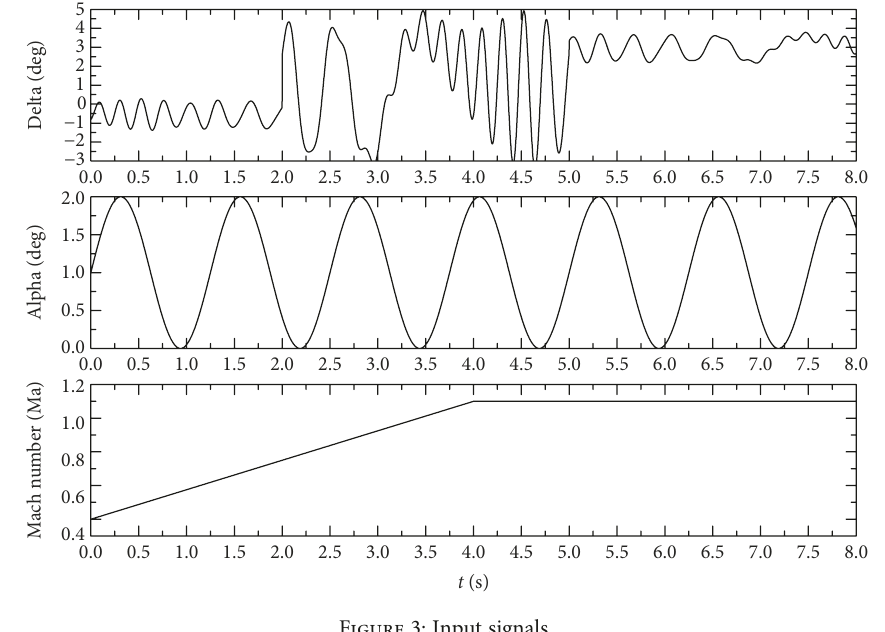
Figure 3: Input signals.